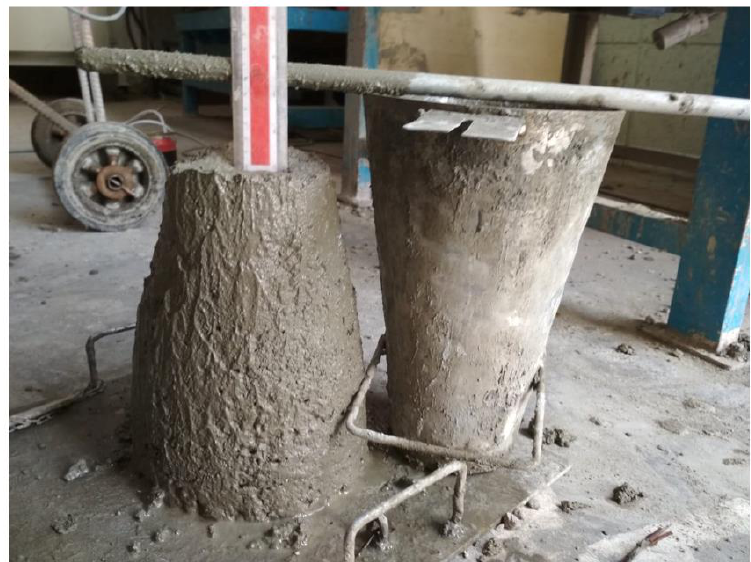
Figure 4. Fresh concrete’ slump test.